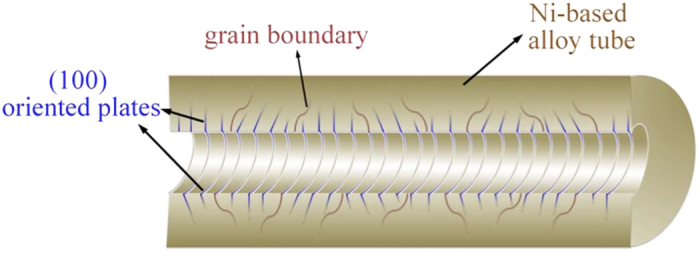
Schematic model of a tube with internal Ni3Al nanoplates microstructure.